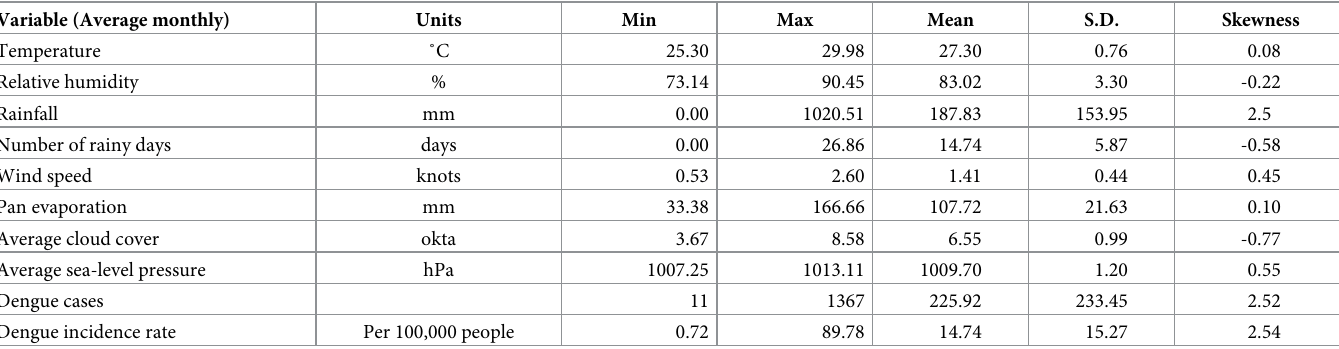
Table 1. Descriptive statistics of explanatory and response